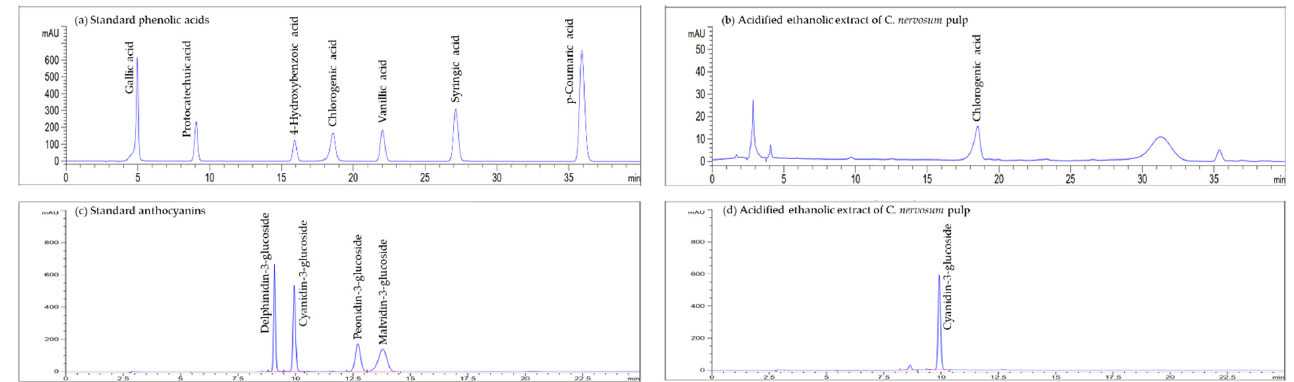
Figure 1 . HPLC chromatograms of ( a ) mixtures of standard phenolic acids, ( b ) phenolic acids in acidified ethanolic extract of C. nervosum pulp, ( c ) mixtures of standard anthocyanins, and ( d ) anthocyanins in acidified ethanolic extract of C. nervosum pulp.